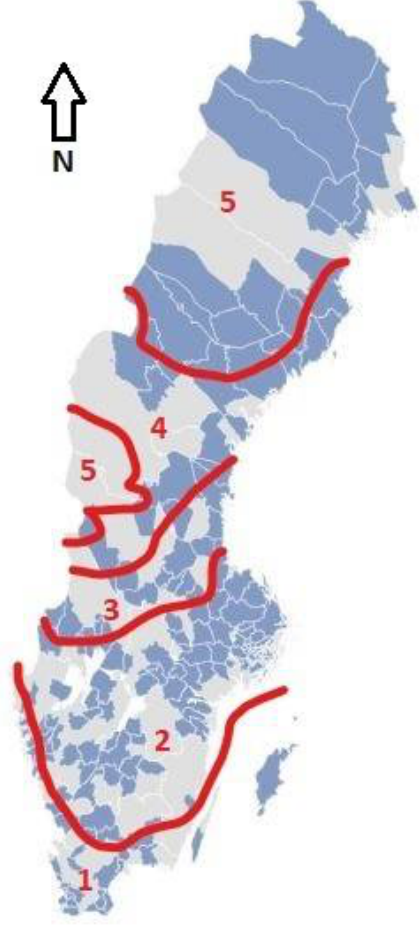
Figure 2. The responding municipalities (blue) in the survey are evenly distributed throughout Sweden, with a small overweight in the Metropolitan region of the capital Stockholm (salient in the central eastern part of the country). The red lines and numbers indicate the climate zones [18], corresponding to a freezing index of 300, 600, 1000, and 1200 °Cd, from south to north.